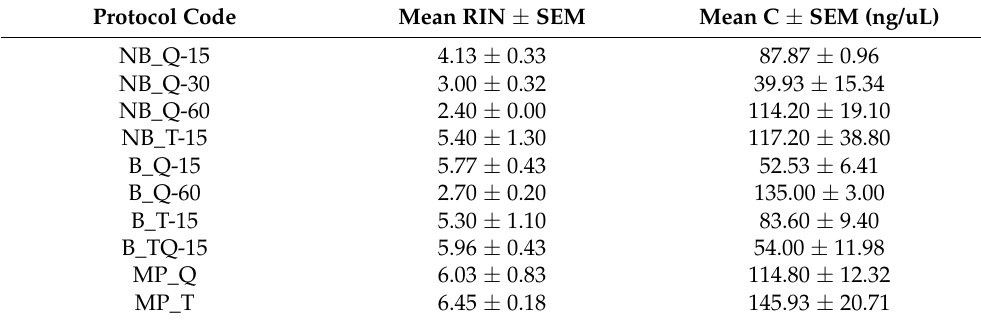
Table 3. Mean concentrations and RINs.